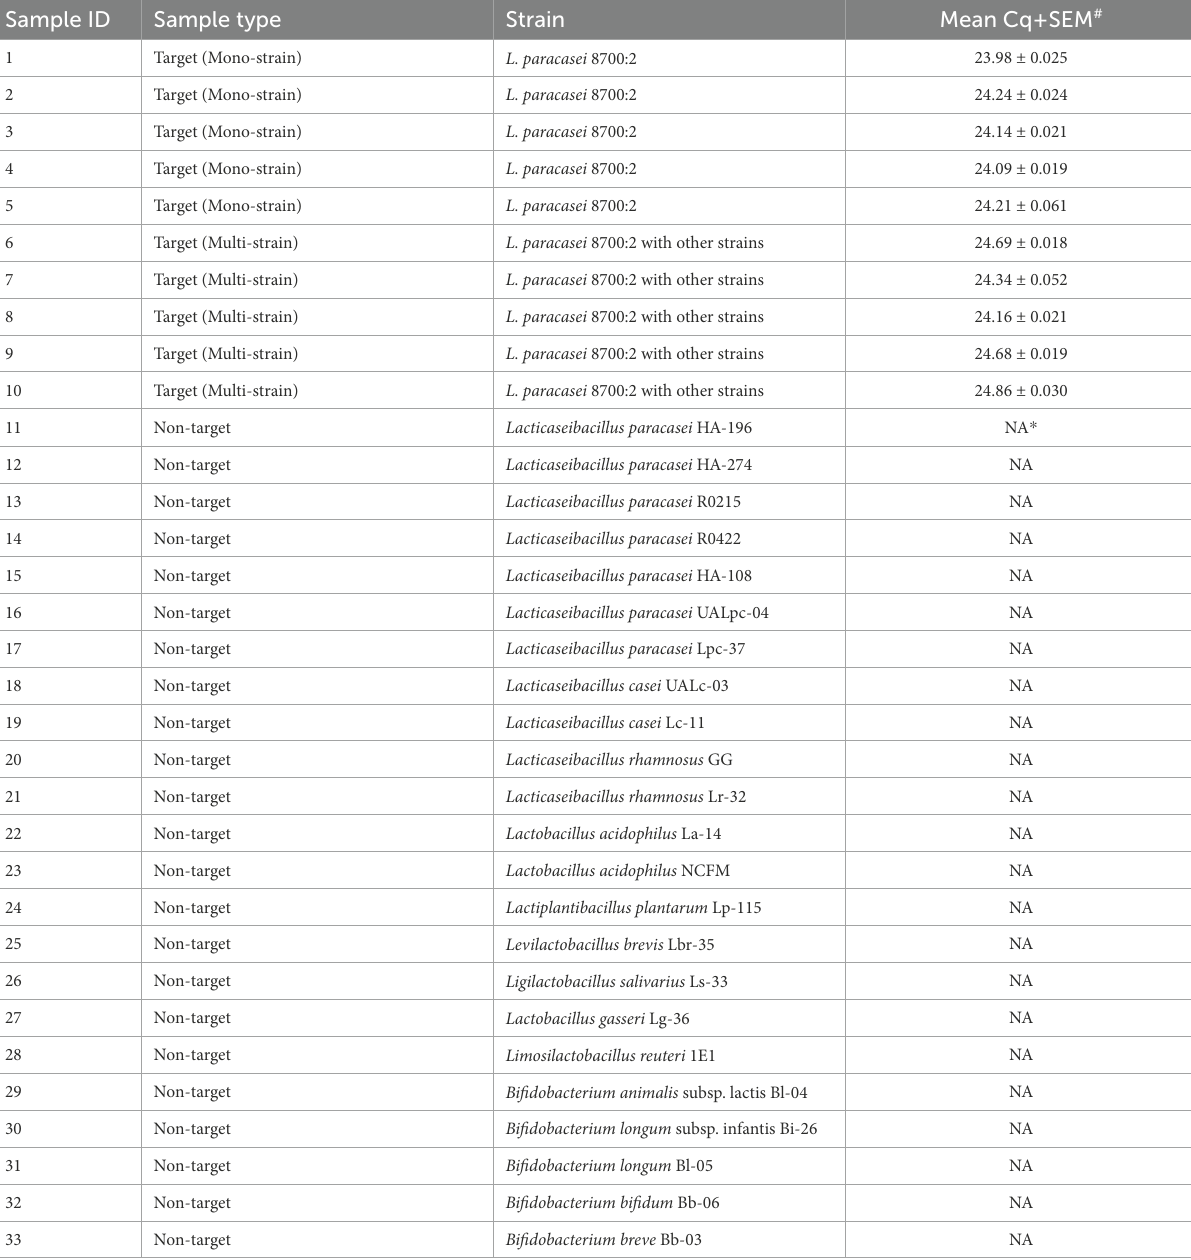
TABLE 1 Samples used to evaluate the analytical specificity of Lacticaseibacillus paracasei 8700:2 strain-specific assay and results for analytical specificity testing. Sample